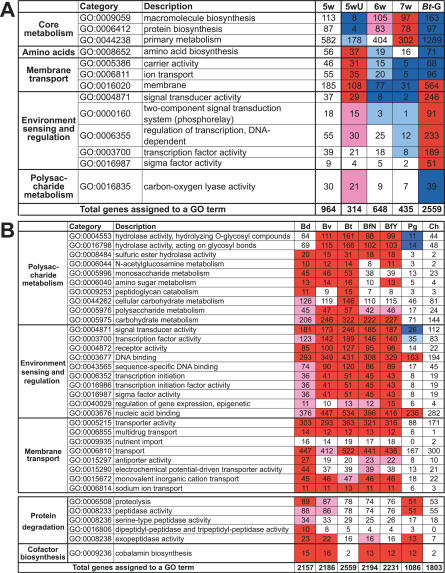
Sensing, Regulatory, and Carbohydrate Metabolism Genes Are Enriched among All Gut-Associated BacteroidetesThe number of genes assigned to each GO term from each genome is shown. Significant enrichment is denoted by pink (p < 0.05) or red (p < 0.001), whereas depletion is indicated by light blue (p < 0.05) or dark blue (p < 0.001), as calculated by a binomial comparison followed by Benjamini-Hochberg false-discovery rate correction (see Materials and Methods).(A) Genes assigned to GO terms related to core metabolic functions are enriched in the subset of common gut-associated Bacteroidetes orthologs shared with non-gut Bacteroidetes (seven-way comparison; abbreviated 7w), compared to the reference set of 1,416 orthologs common to the five sequenced gut Bacteroidetes genomes (5w), suggesting that all Bacteroidetes have inherited a core metabolome from their common ancestor. The set of orthologs that is not shared with non-gut–associated Bacteroidetes (five-way unique; 5wU) is enriched, relative to all orthologs (5w), for genes in three classes—amino acid biosynthesis; membrane transport; and two-component signal transduction systems—suggesting that these genes were important in the process of adaptation to the gut and/or other habitats by the common ancestor of gut Bacteroidetes.(B) Various GO terms related to environmental sensing, gene regulation, and carbohydrate degradation are enriched in gut Bacteroidetes relative to Cy. hutchinsonii (Ch). A similar pattern is observed relative to P. gingivalis (Pg) (unpublished data). Note that these same classes of genes are depleted in the subset of shared gut Bacteroidetes orthologs ([A] 5w) relative to the full B. thetaiotaomicron (Bt) genome ([A] Bt-G). Thus, these classes of genes, though enriched in all gut Bacteroidetes, are widely divergent between them. Other classes of genes vary between species: B. distasonis (Bd) and B. vulgatus (Bv) show an expanded repertoire of proteases, whereas B. thetaiotaomicron lacks genes involved in synthesis of cobalamin. 6w refers to the orthologs shared by the five sequenced gut Bacteroidetes genomes (Bt, Bv, Bd, plus two B. fragilis strains [NCTC 9343 (BfN) and YCH 46 (BfY)] and Pg.